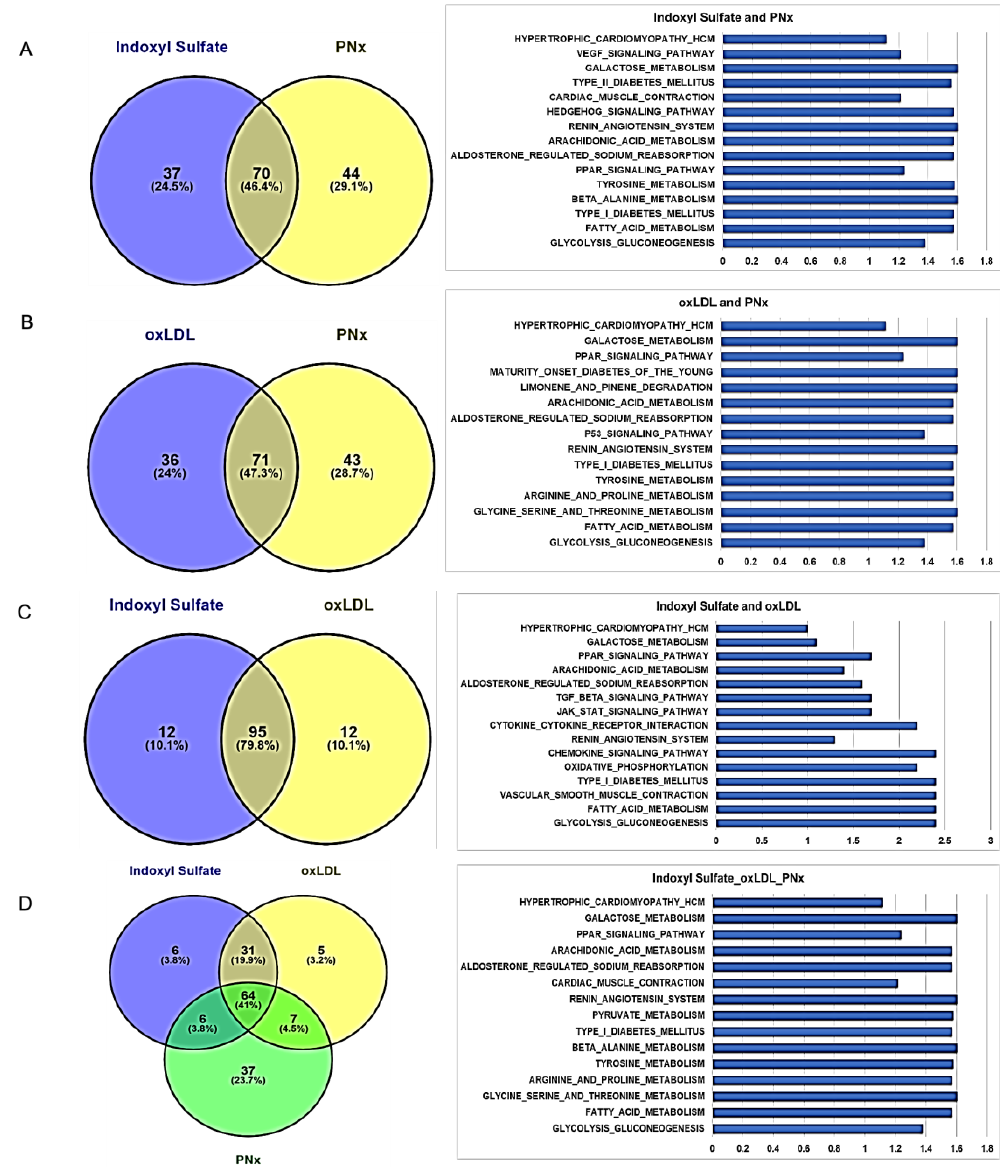
Figure 6. Pathway enrichment analysis using genes differentially expressed in vitro and in vivo in response to oxidative stress. The in vitro (oxLDL and IS treatment) and in vivo (PNx mouse model) response to oxidative stress differs in pathway enrichment, but some pathways overlap. The Venn diagram depicts the overlap of all enriched pathways among in vitro and in vivo, with selected common pathways (15 most relevant) and their BH-adjusted p -values depicted adjacent to the Venn diagram. Enriched pathways with little relevance to adipocyte biology have been omitted for clarity. Overlap of common pathways between ( A ) IS treatment and PNx mouse model, ( B ) oxLDL treatment and PNx mouse model, ( C ) IS and oxLDL treatment, and ( D ) in vitro (IS and oxLDL treatment) and in vivo (PNx mouse model).